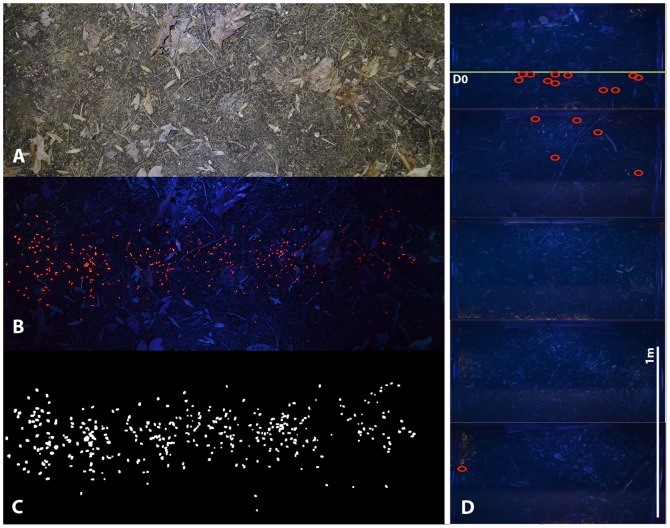
Transect Imagery.Example of Q1 with ambient light (A), UV assisted imagery (B), and its conversion to black and white (C) for automated analysis. The compiled UV images of an entire transect (D) with dispersed seed marked in red circles and 1 m scale bar.